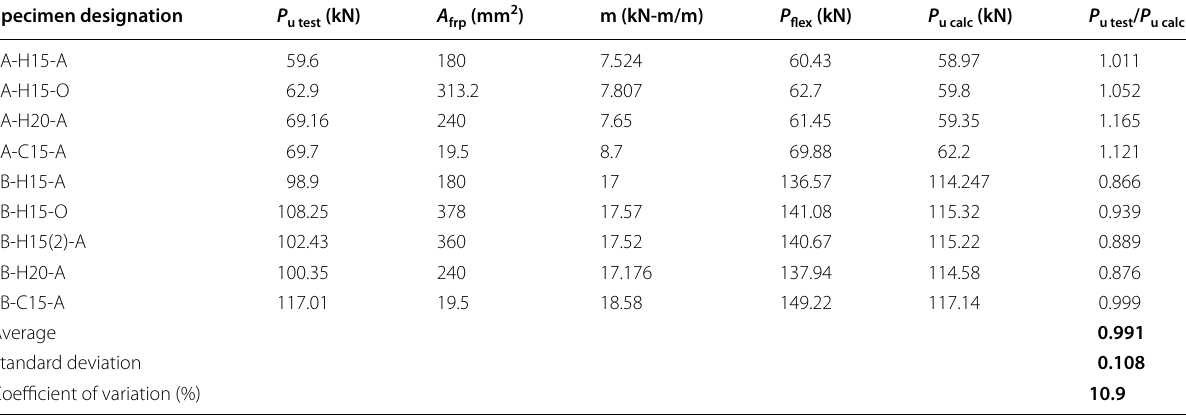
Table 11 Comparison between experimental and analytical